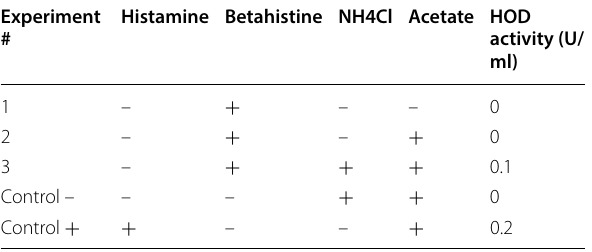
Supplementary information Table 2 The effect of betahistine on HOD production